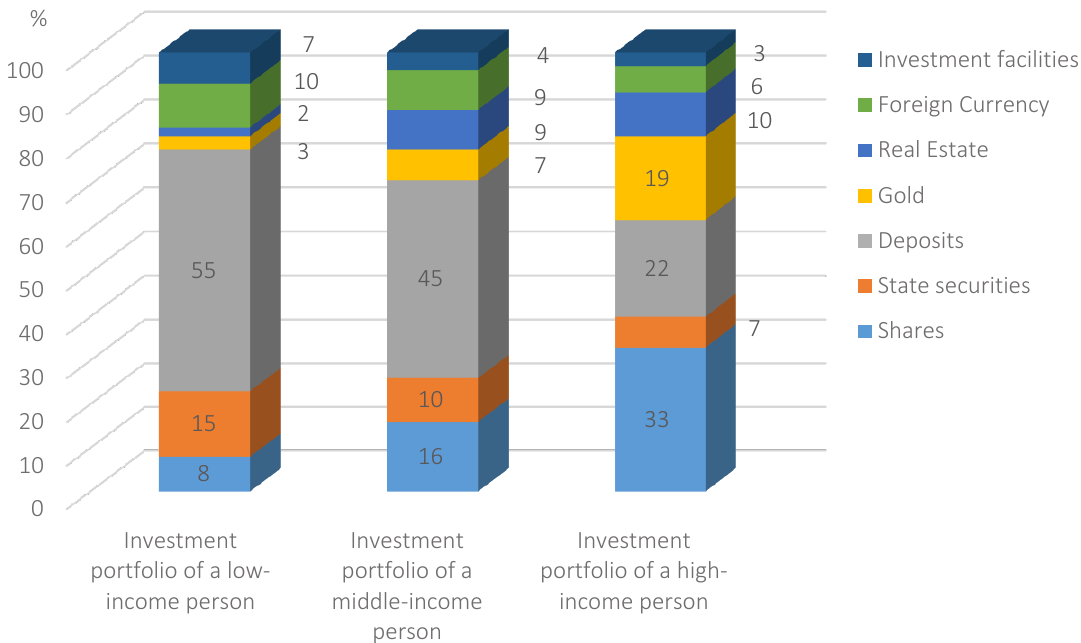
Figure 4. Personal investment portfolio of an individual with low, middle and high income in 2019,